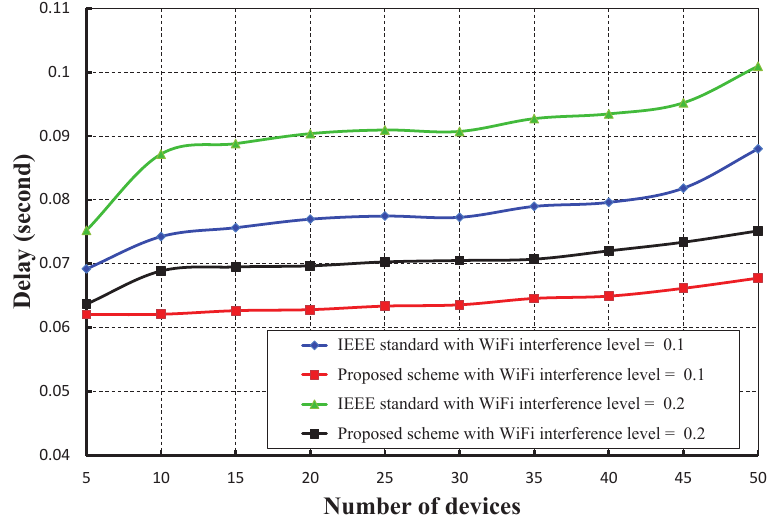
Figure 22. Comparison of the delay of our scheme with the IEEE 802.15.4e standard under different WiFi interference